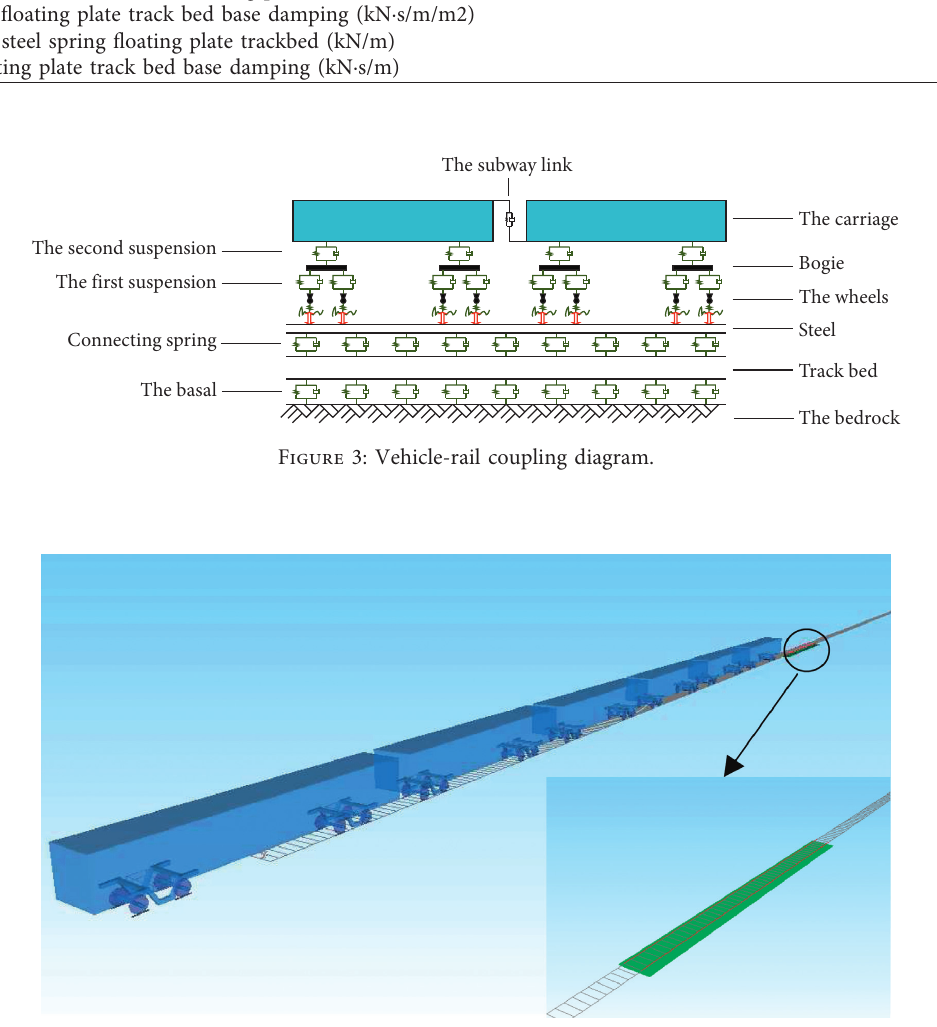
Figure 4: Effect diagram of rail coupling.